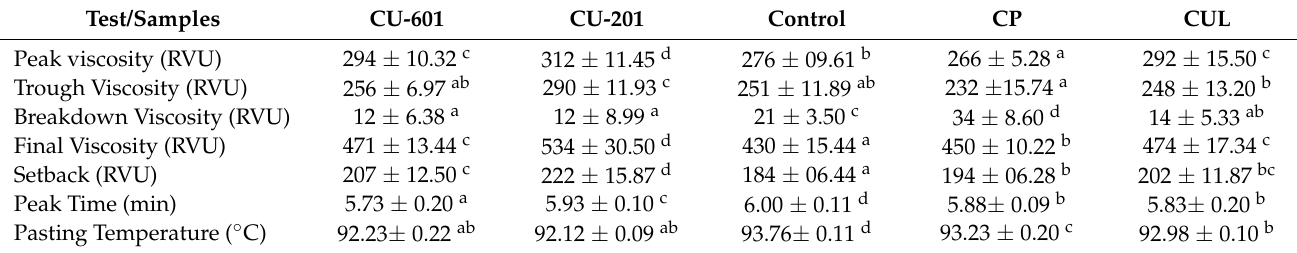
The results of pasting properties are mean and standard deviation of triplicates of each treatment, respectively. Different letters (a–d) in rows indicate the significant difference between processing methods at p < 0.05 using one way ANOVA and Duncan’s multiple range test CUL, CP, CU-601, and CU-201 indicate the names of pectin, which were added in